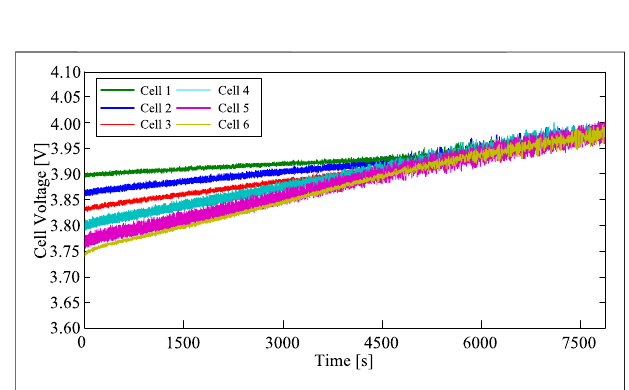
FIGURE 5 | Terminal voltages of six cells during the charging process with a dynamic acceleration coef fi cient adaptive